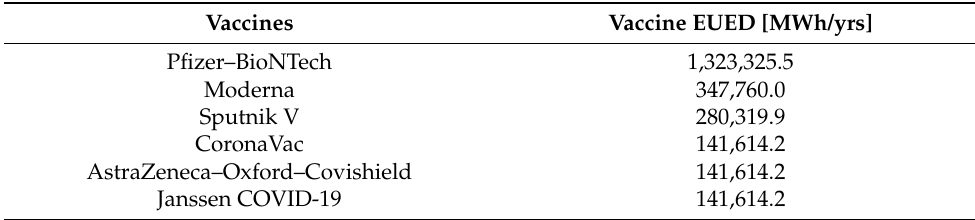
Table 8. Vaccine EUED world yearly.